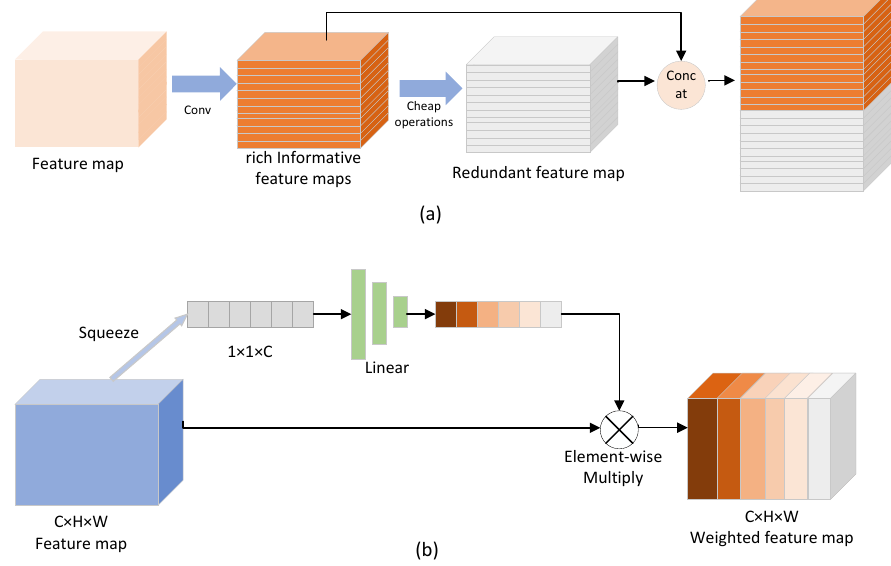
Figure 3. The structures of the Ghost Block and SE block. ( a ) The Ghost Block structure, where Conv denotes the convolution operations, and cheap operations denote linear transformation; ( b ) the SE block